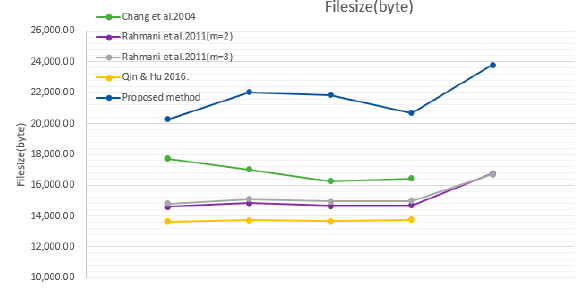
Table 8. Total bitrate, data bitrate, and image bitrate of SOC-based schemes.